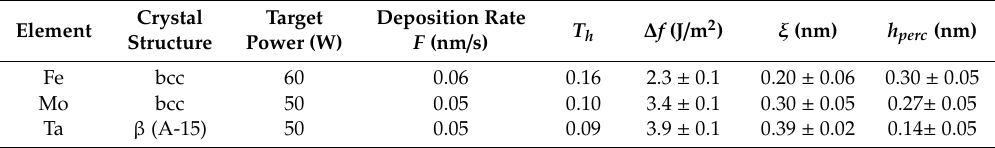
Table 2. Process parameters and physical quantities extracted from real-time stress and resistivity evolutions during growth of Fe, Mo, and Ta films at T = 300 K on a-Si. The Ar working pressure was fixed at 0.24